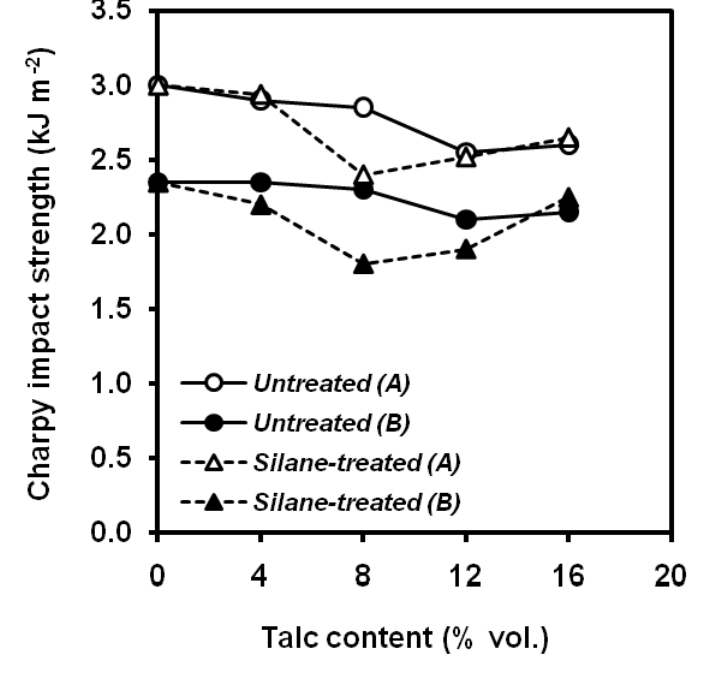
Figure 29. Influence of talc content on the notched Charpy impact strength of (A) non- irradiated and (B) gamma-irradiated PP/talc composites (adapted from